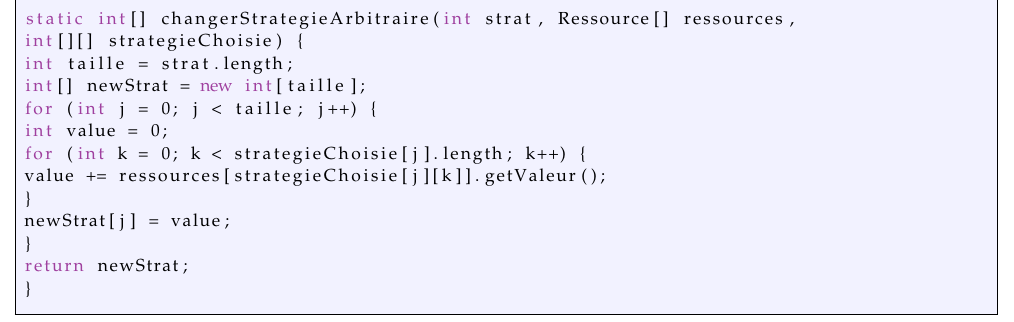
Code A8: Algorithm for strategy conversion